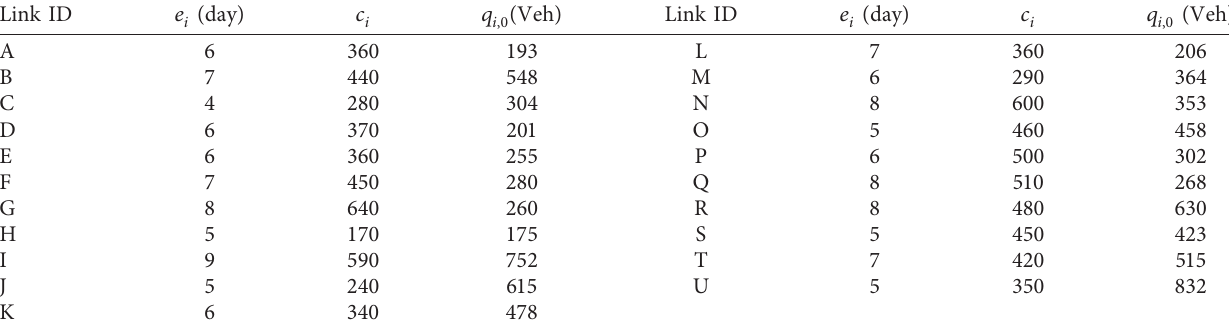
Table 2: Restoration duration and cost of each disrupted link.